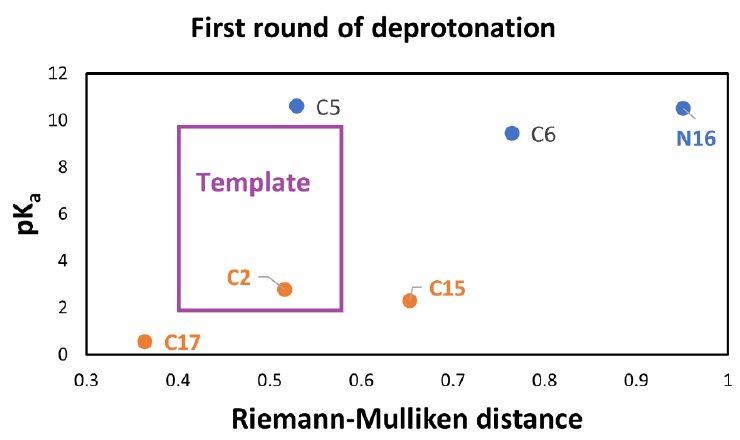
Figure 9. Relation between RMD and pK a values of Bd, and template for clusterization via RMD. The low cluster involves the dihydropyridine ring nitrogen (C2, C15, C17), and the high cluster corresponds to the catechol ring (C5, C6, N16).